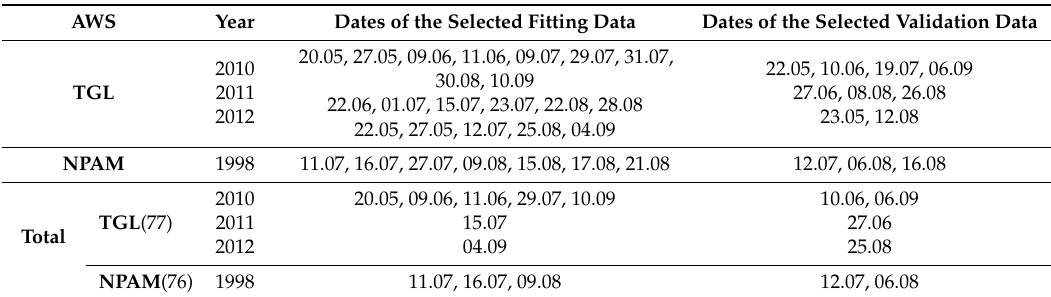
Remote Sens. 2019 , 11 , x FOR PEER REVIEW